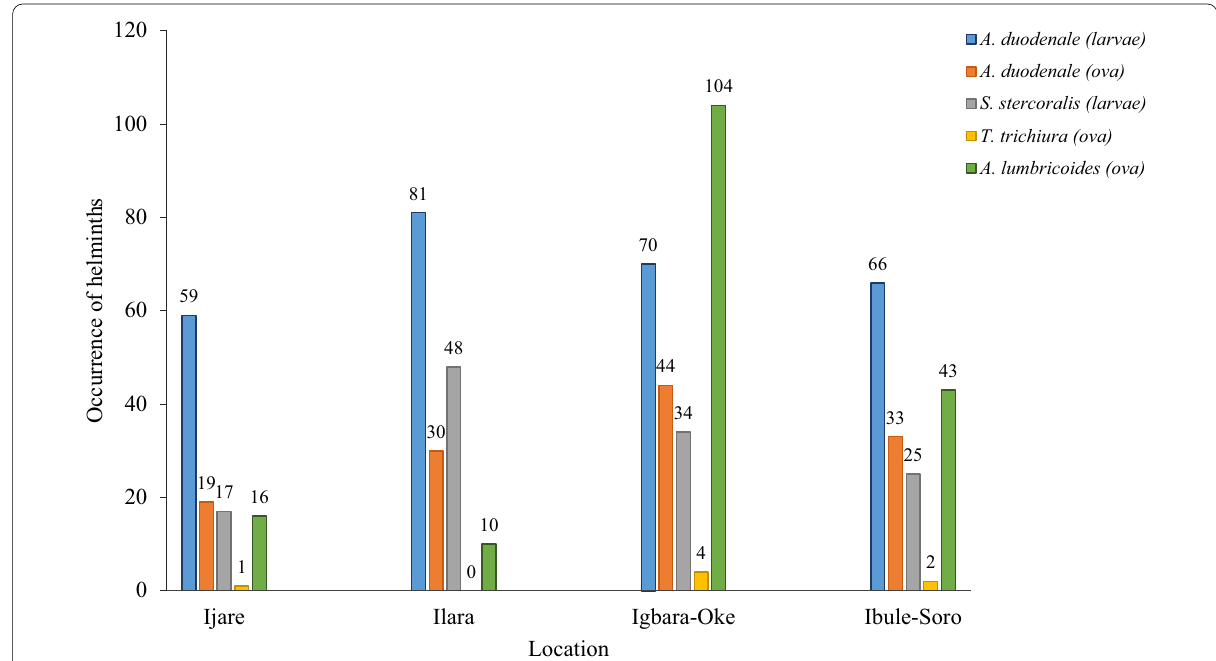
Fig. 1 Occurrence of soil‑transmitted helminths in relation to sample